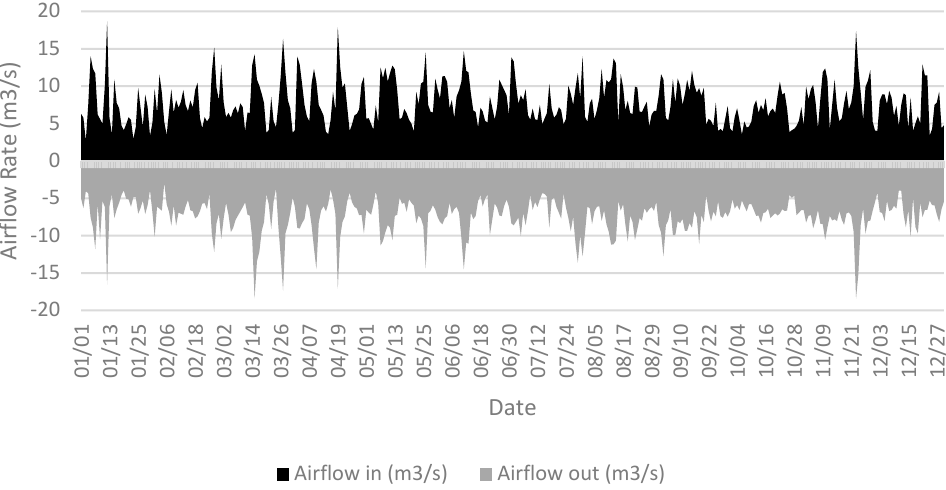
Figure 2. Annual average daily ventilation rate of the building and average outdoor wind speed.